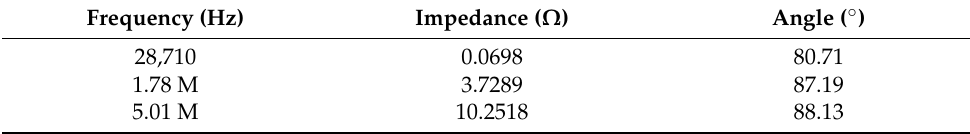
Table 3. Measured points for three branches.